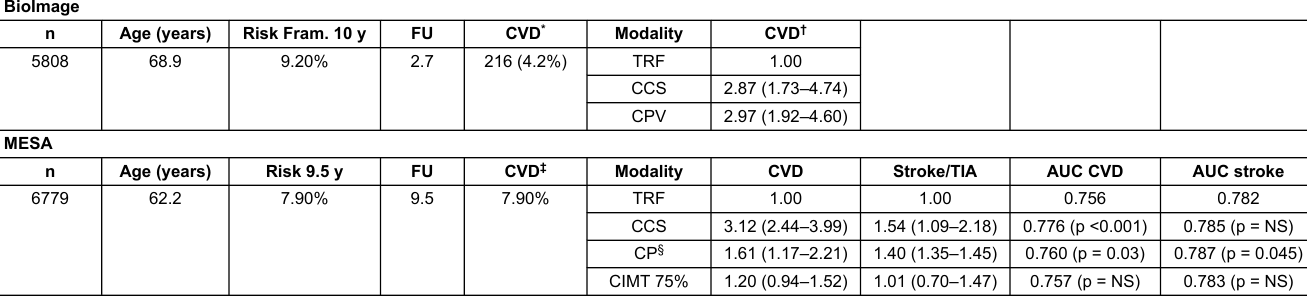
Table 4: Direct comparison of coronary calcium scores with either carotid total plaque / carotid plaque volume or carotid intima media thickness in the BioImage [34] and MESA [65] studies. BioImage